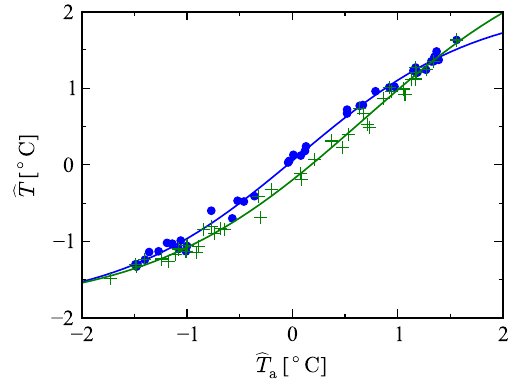
Figure 4. Non-linear relationship between the z scored stream tem- perature b T and the z scored air temperature b T a averaged over 14 ref- erence meteorological stations. The values of b T are obtained by av- eraging in each month the z scored stream temperatures measured at the 21 calibration stations. Each point corresponds to a single month of the calibration period 2007–2012. Months from January to July are displayed as green crosses, and those from July to December as blue dots. The two solid lines correspond to the respective fits of the data points in the two year halves (see Eqs.